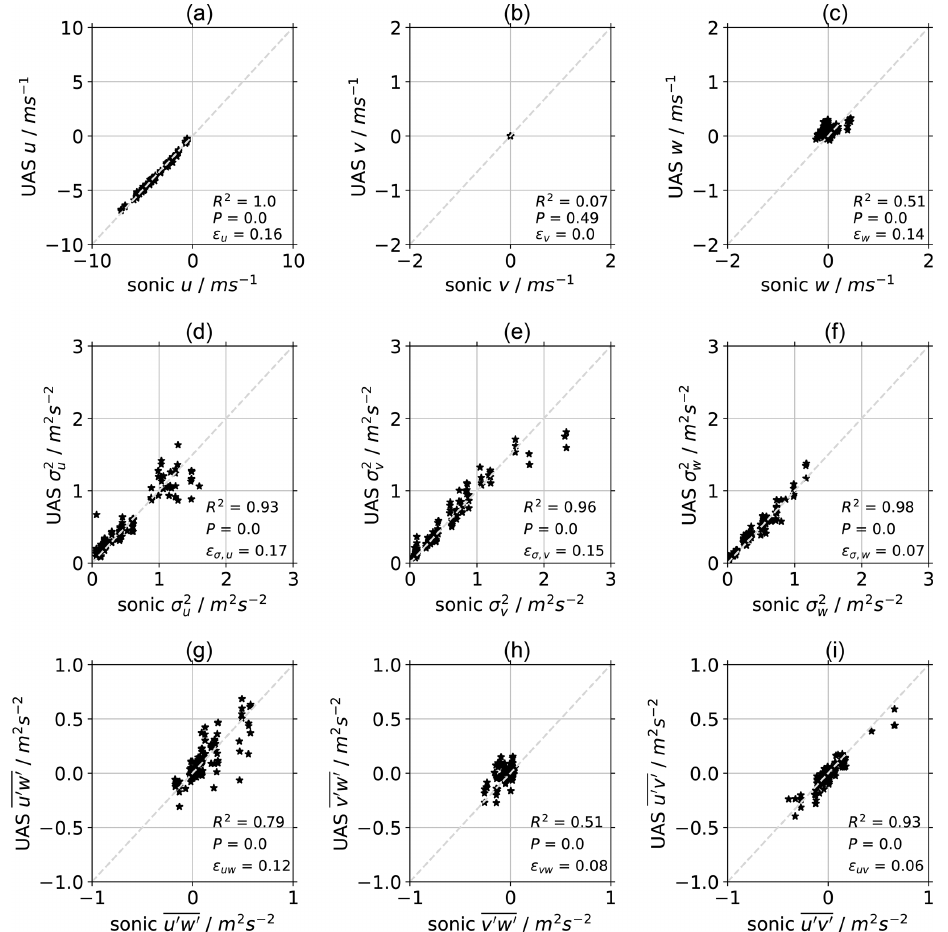
Figure 8. Scatterplots of flight-averaged UAS measurements versus sonic anemometer for u , v , and w (a–c) , as well as the corresponding variances (d–f) and covariances (g–i)